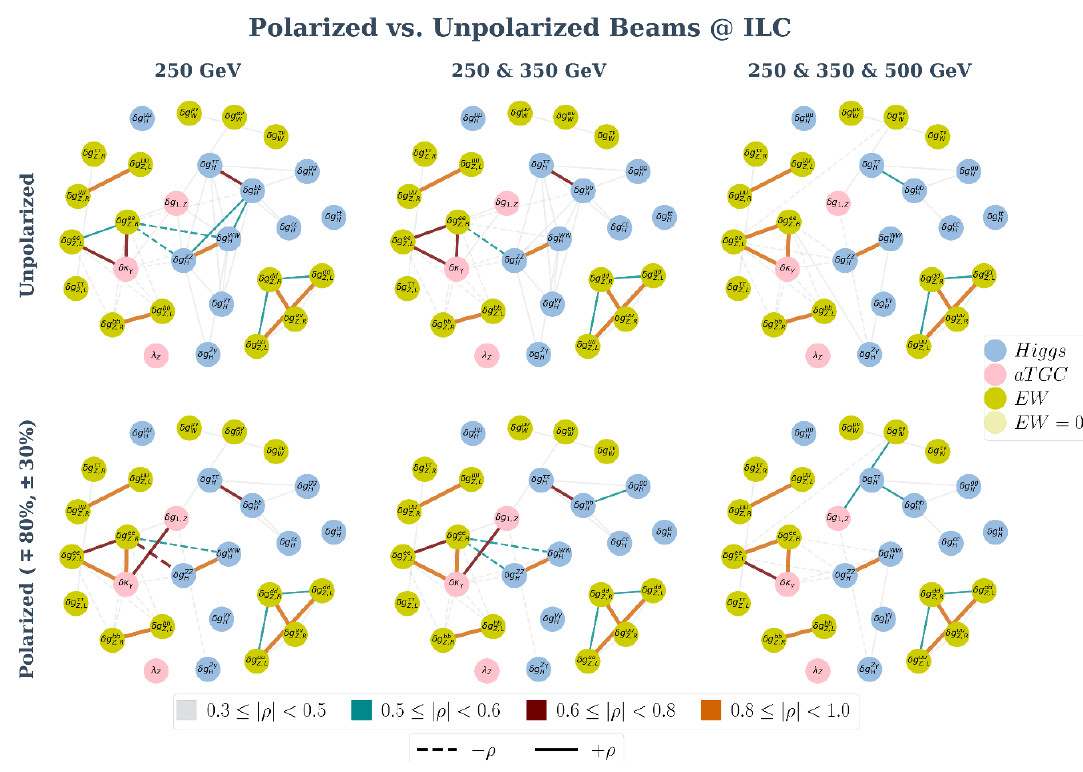
Figure 9 . A comparison of correlations between the di(cid:11)erent sectors for polarized beams ( (cid:7) 80% ; (cid:6) 30%) and unpolarized beams at the ILC. HL-LHC projections have been